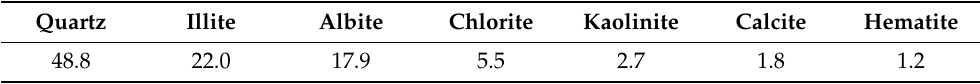
Table 3. Mineral composition of soil used (in